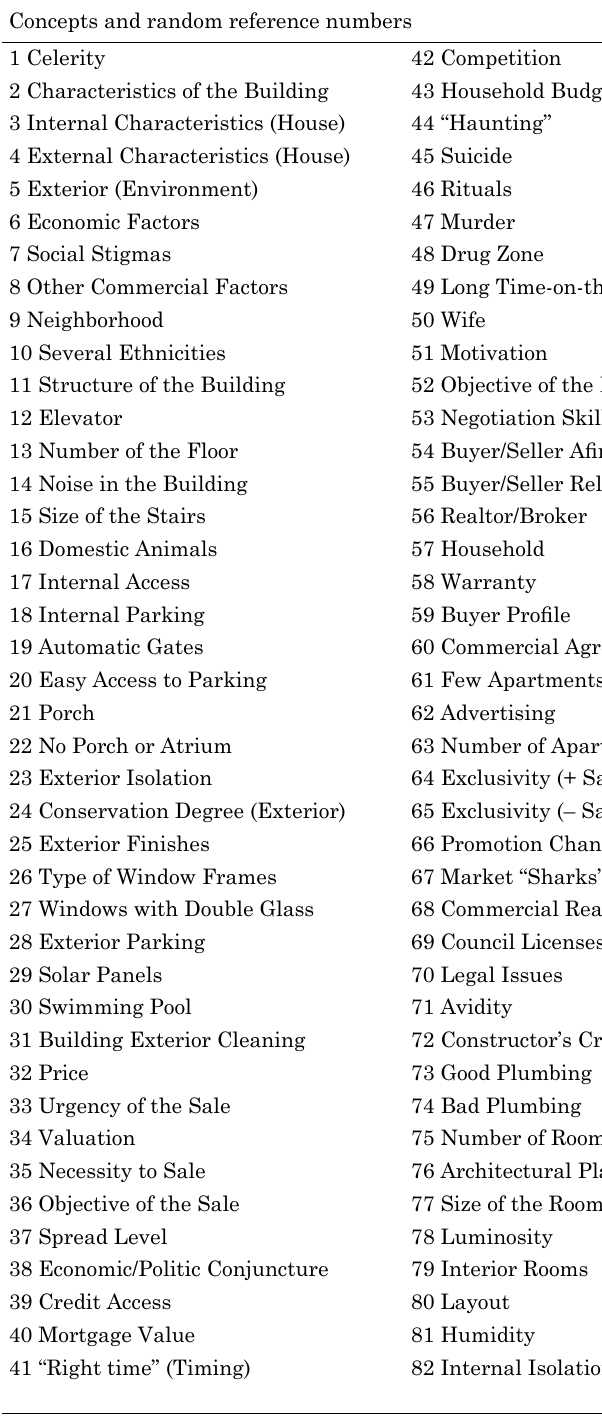
Table 1. List of concepts resulting from the application of the “post-its